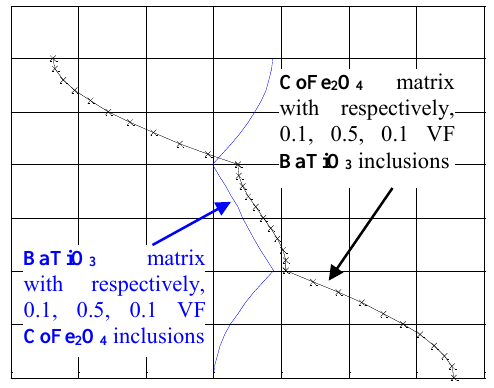
Figure 4 : Variation of the electric potential along the thickness direction in the sandwich plate caused by a surface